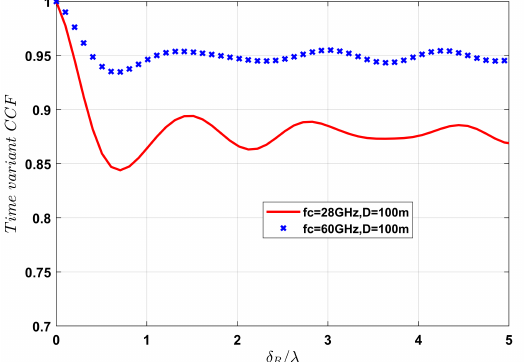
Figure 8. The absolute values of the time-variant space CCF at f c = 30 GHz, f c = 60 GHz and close distances of D s = 100 m at v R = 360